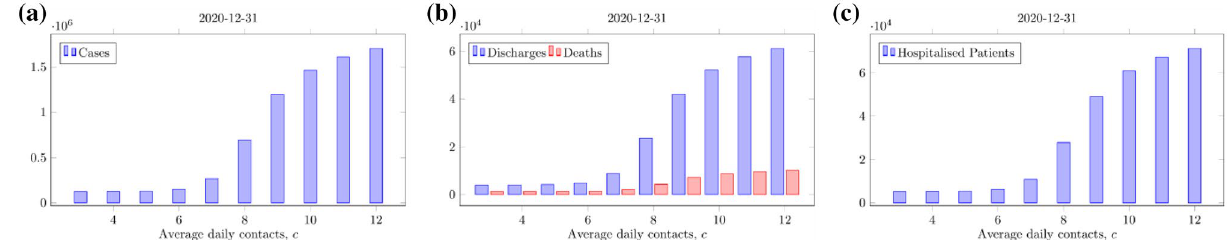
Figure 4. Cumulative number of COVID-19 cases ( a ), hospital discharges and deaths associated with COVID- 19 ( b ) and hospitalised patients with COVID-19 ( c ) for different levels of compliance with social distancing quantified by the number of daily contacts, c , from 4 July 2020. The cumulative totals for 2020 are considered, including forecasts up to 31 December 2020. For c > 6 the number of cases, deaths, hospitalised patients and discharges increase significantly. The results shown here assume an infectiousness period of 5 days and that symptomatic infections comprise 70% of all infections.